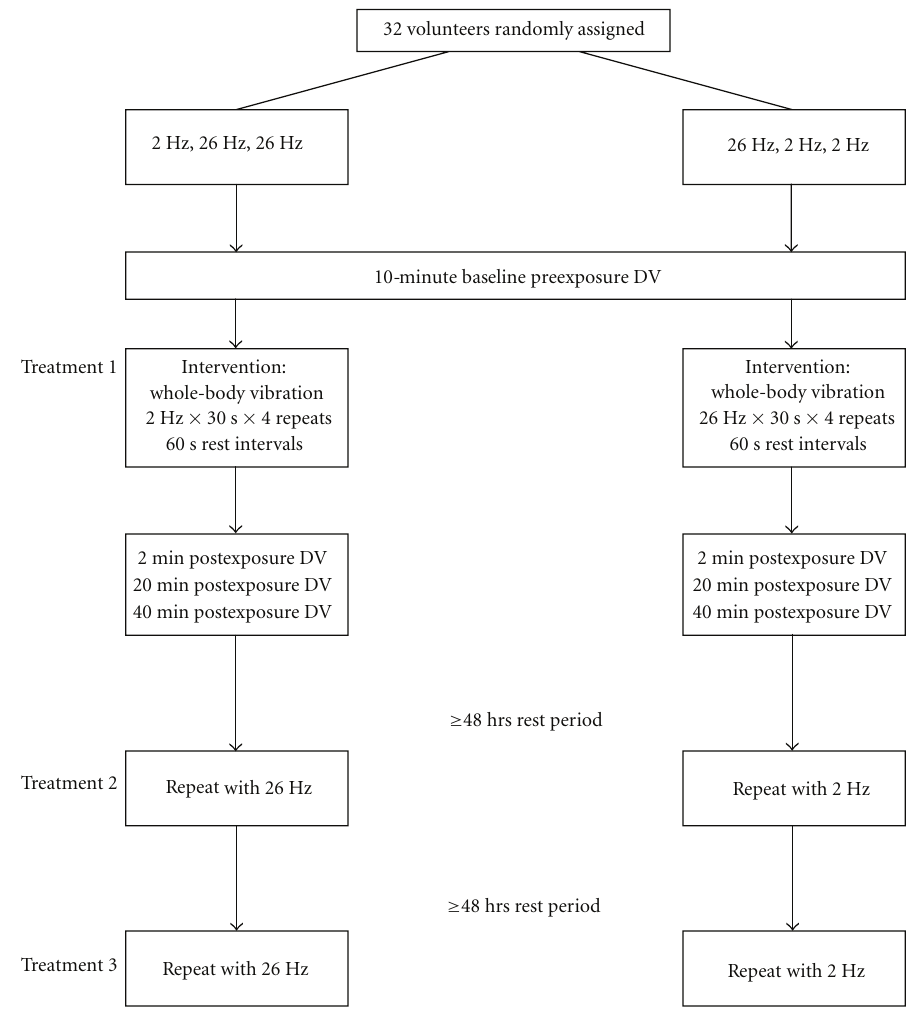
Figure 1: A schematic presentation of the experimental procedures. Inclusion criteria were ≥ 65 years old, live in the community, and able to comfortably walk at least 150 feet without an assistive device. Exclusion criteria were acute thrombosis, acute inflammation, acute ten- dinopathy, fresh fractures, gallstones, implants (pacemaker, breast implant, buttock implant, screws, pins, pumps, wires), recent surgery, acute hernia, acute discopathy, acute migraine, fresh wound/scar, epilepsy, total knee replacement, total hip replacement, infectious disease, uncontrolled diabetes, neuromuscular disease, and osteoporosis. Abbreviations: DV, dependent variables; TGUG, timed get up and go; OLST, one-legged stance test; CMJ, counter movement jump; CSR, chair sit and